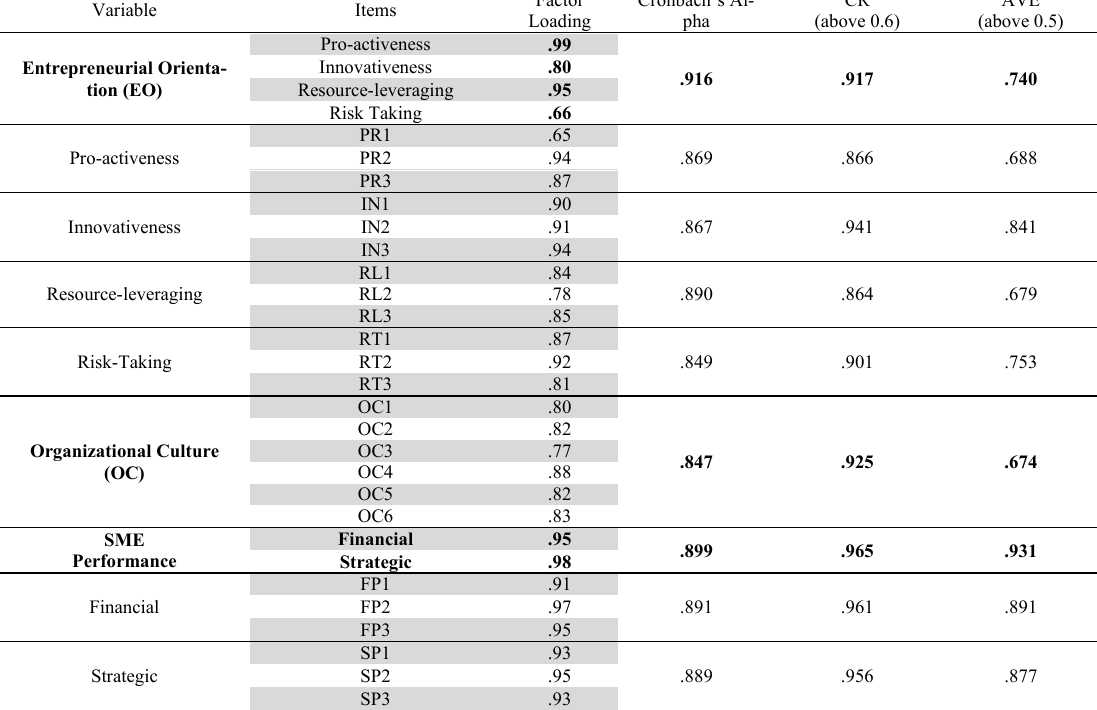
The C odelMFA Result for the